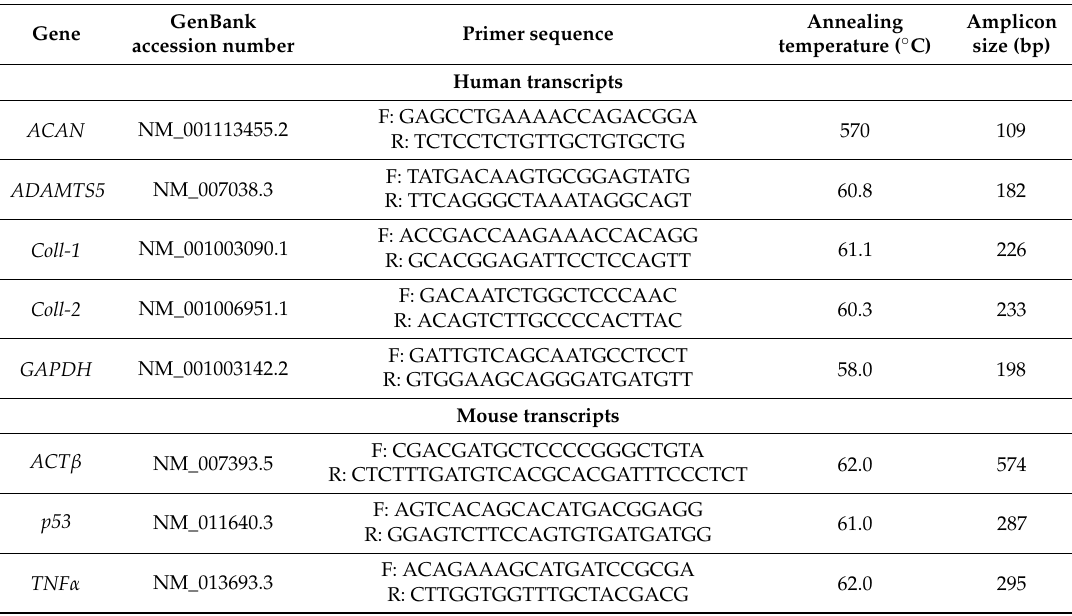
Table 2. Sequences of primers used in